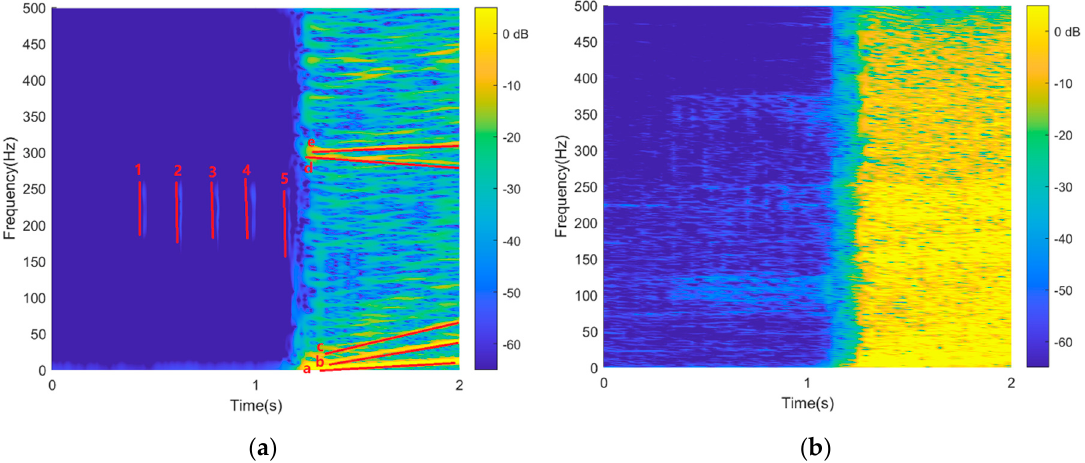
Figure 5. Common mode voltage of linear generation output in the ( a ) time domain and ( b ) frequency domain.